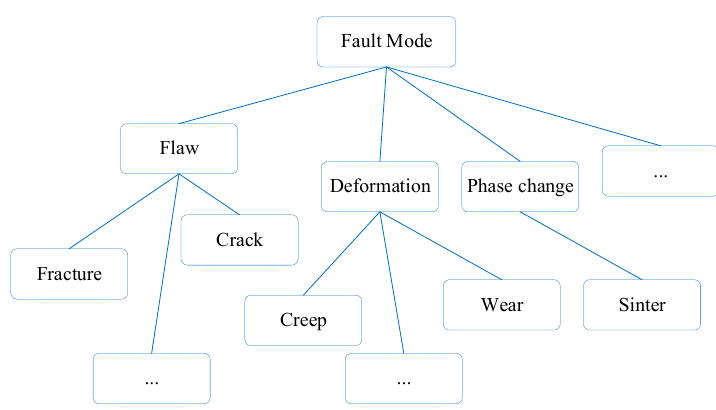
Figure 2. Tree structure of fault part.